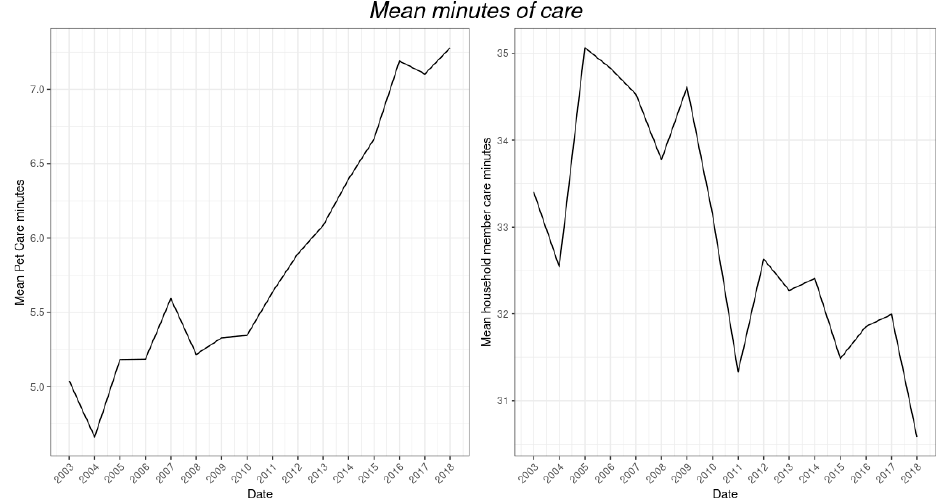
Figure 2. Average minutes of care weekly for pets ( left ) and household members ( right ).